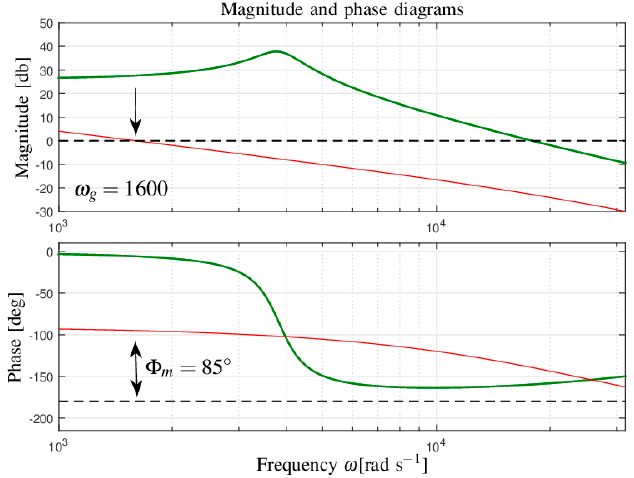
Figure 4. Bode diagrams of the frequency response of the buck converter (green), and of the open loop frequency response with the discrete-time inversion formulae (red).